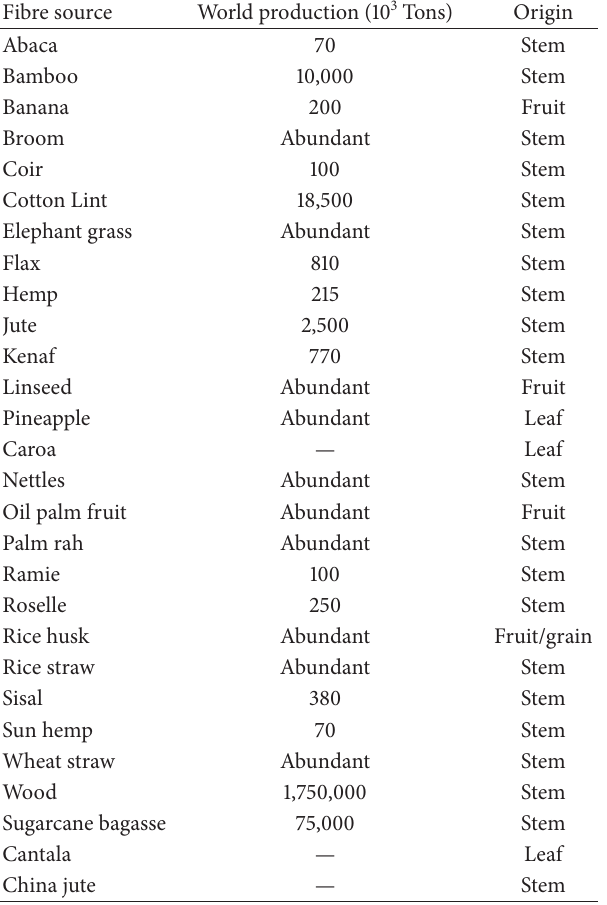
Table 1: Annual production of natural fibres and sources